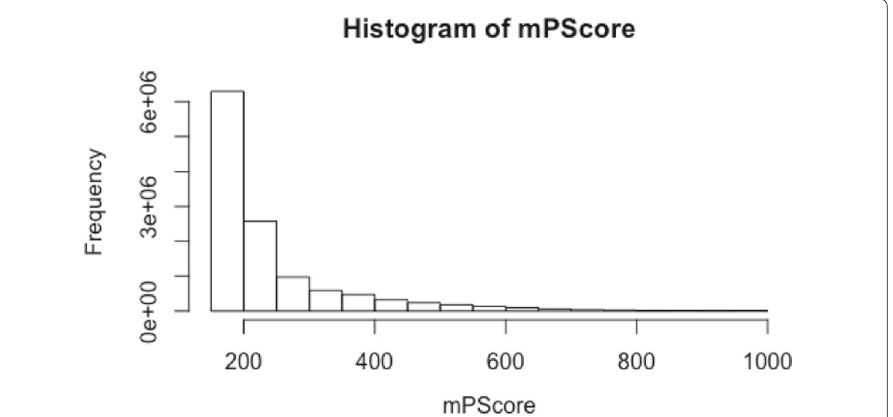
Fig. 13 The distribution of the combined score extracted from the open STITCH data